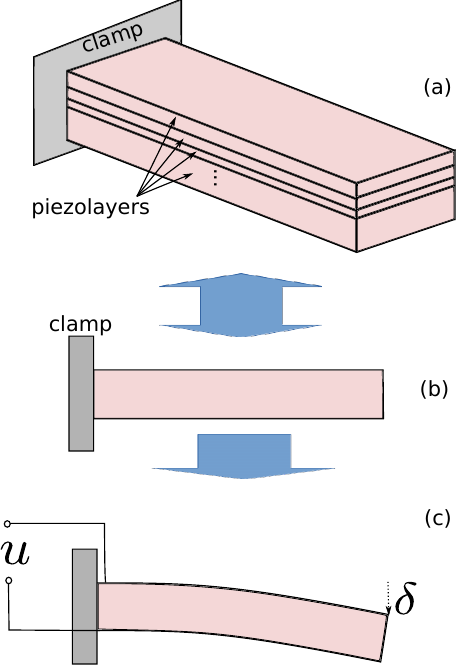
Figure 1. A piezoelecric cantilevered actuator. ( a ) Isometric scheme depicting the PEA’s piezolayers; ( b ) Side view of a PEA; ( c ) bending displacement resulting as a result of the application of an input voltage u